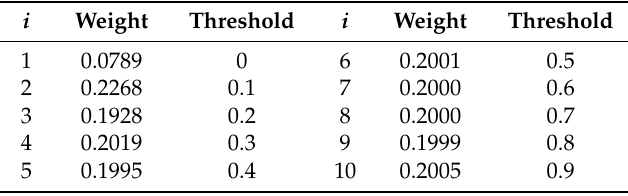
Table 1. Parameters of the Prandtl-Ishlinskii (PI) model.